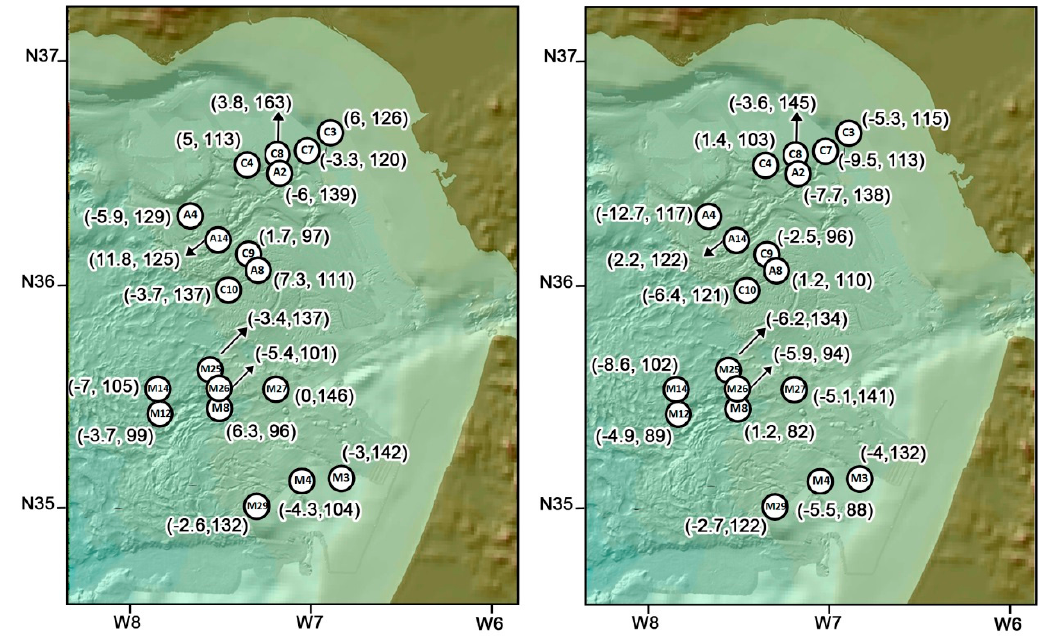
Figure 9. Gulf of Cádiz bathymetric map modified from [60] showing mud volcanoes locations with B isotopes and abundances in each sample: (Left) Mannitol washed samples; and (Right) NH 4 Cl exchanged samples. Values in brackets are δ 11 B (‰), B content (ppm).